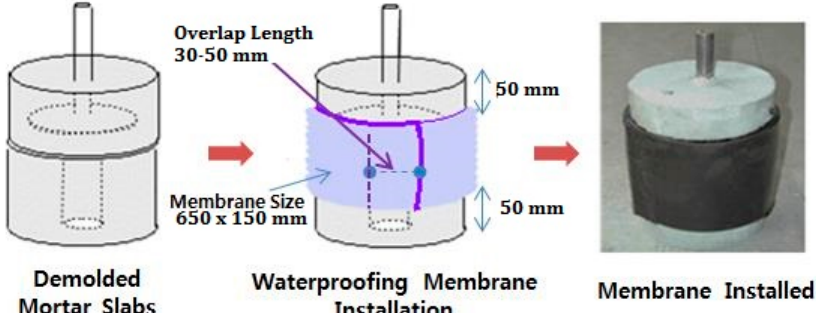
Figure 4. Waterproofing membrane installation dimension.